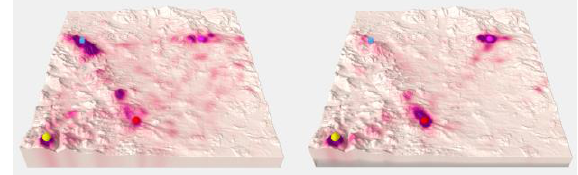
Fig. 9. Comparison of 3D attention maps from cartographers (left) and non-cartographers (right) for variant B, task 6. Interactive versions are available at http:// eyetracking.upol.cz/3d .